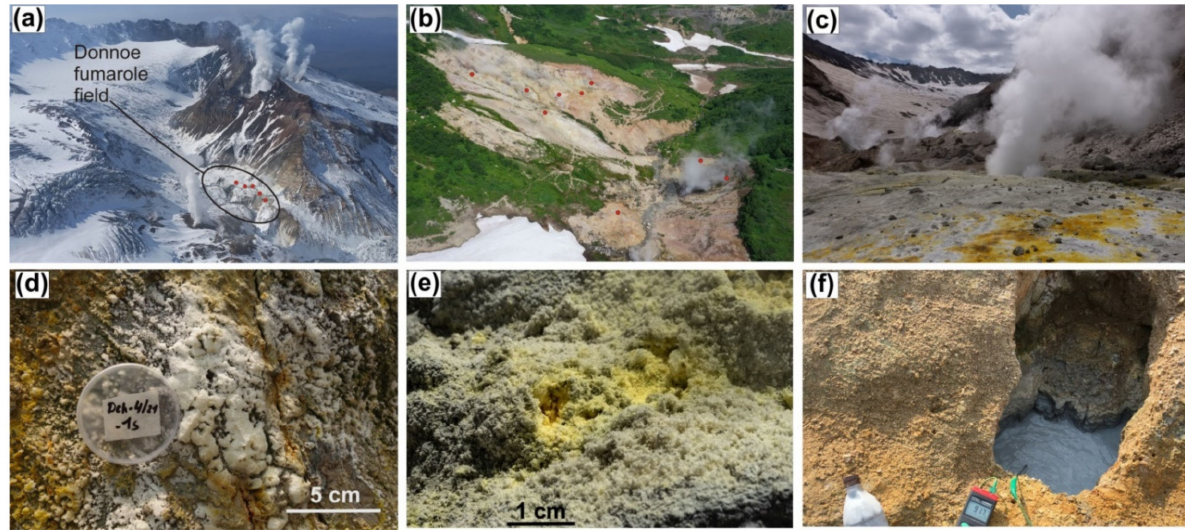
Figure 2. Sampling schemes of Donnoe fumarole field ( a ), Dachnoe thermal field ( b ), the view to Donnoe fumarole field ( c ), efflorescent minerals from Dachnoe thermal field ( d ), and Donnoe fumarole field ( e ), bubbling pools from Dachnoe thermal field ( f